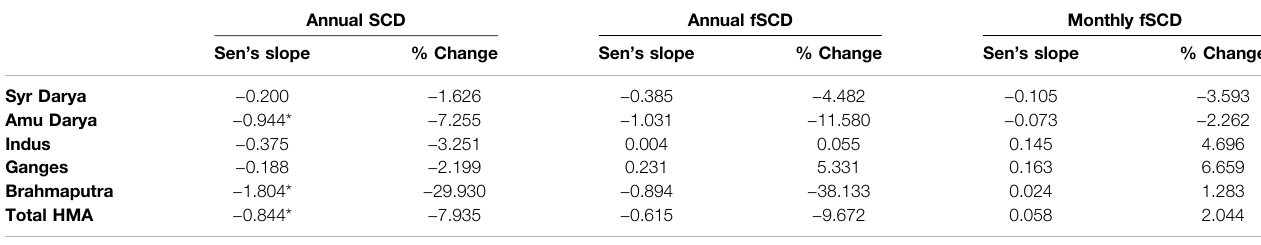
TABLE 1 | Slope of annual and monthly SCD and fSCD for each basin and the total HMA region, including the associated percent change for each metric.